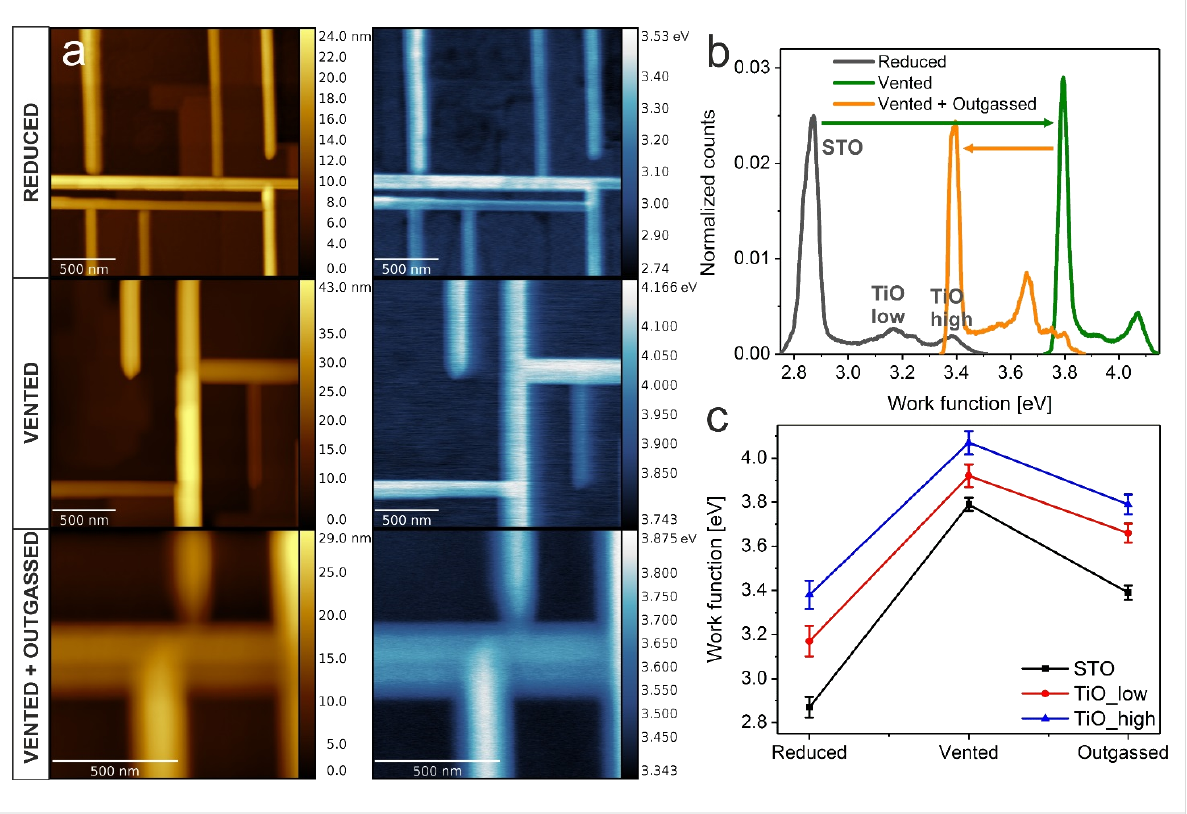
Figure 6: Influence of air exposure on the TiO/SrTiO 3 work function. a) KPFM topography and work function of a TiO/SrTiO 3 heterostructure ( Δ f = − 40 Hz) after reduction (first row), exposed to ambient air (second row) and after annealing up to 230 °C (third row). b) Work function histograms of the presented cases. c) Evolution of the work function value for the SrTiO 3 (100) surface (black), lower TiO facets (red) and higher